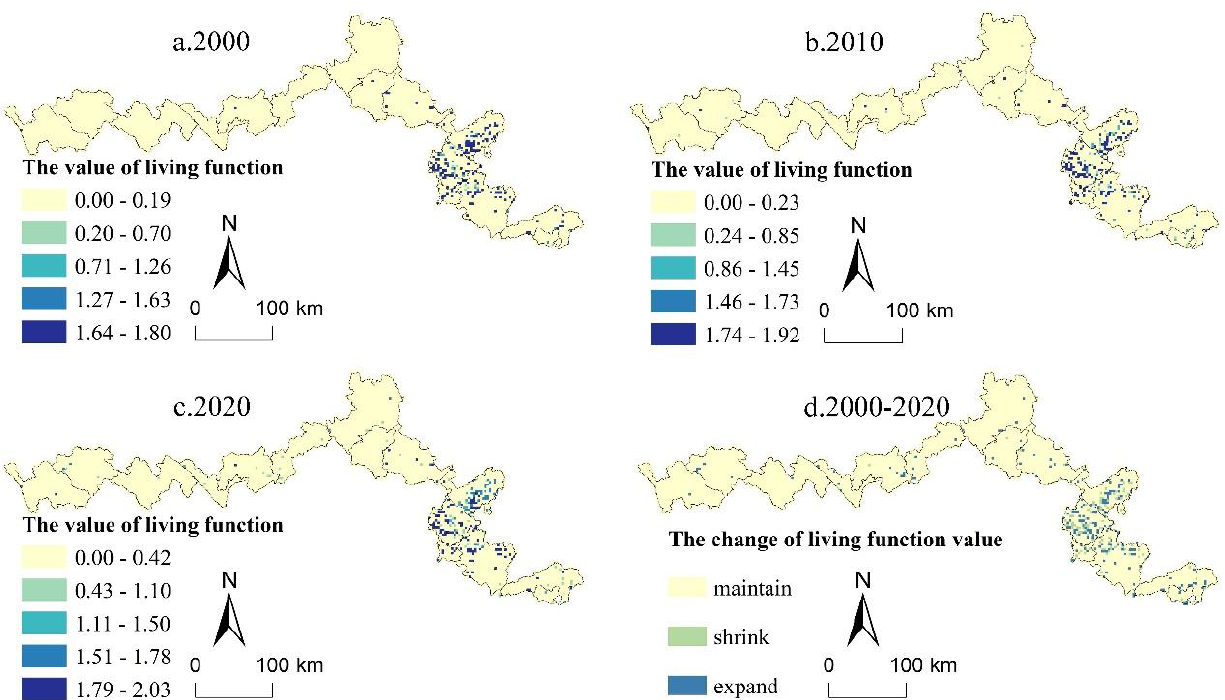
Figure 3. Living function value in the Sino–Vietnamese border region in ( a ) 2000, ( b ) 2010, ( c ) 2020 and ( d ) the change between 2000 and 2020.